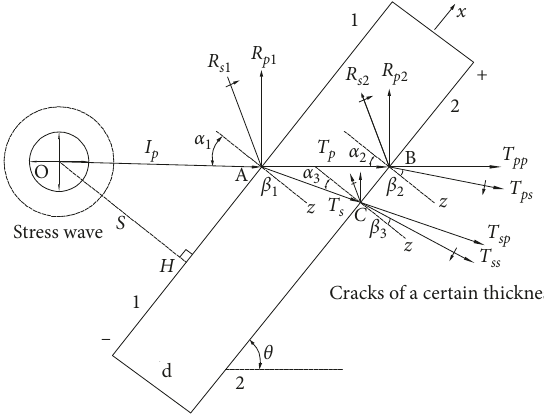
Figure 2: Interaction between the stress wave and the